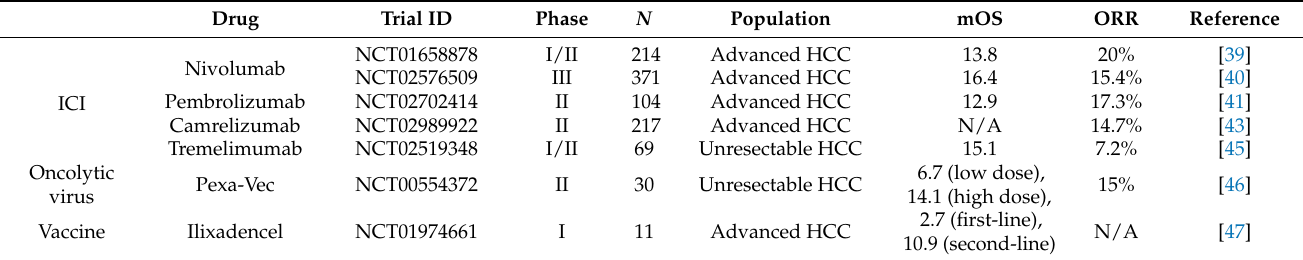
Table 1. Selected clinical trials of single-agent immunotherapy for